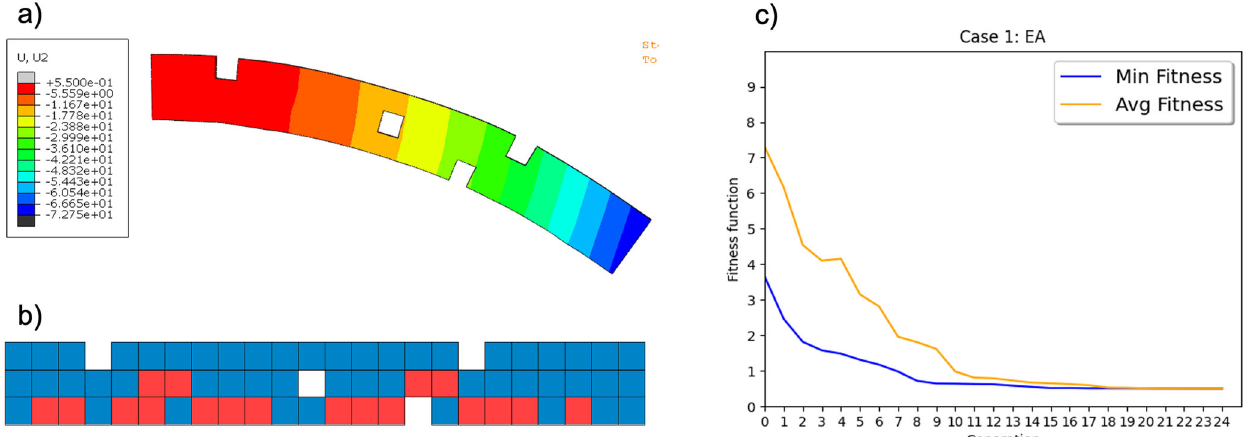
Fig. 8 The results for the fi rst case study. ( a ) the displacement of the optimal solution, ( b ) the optimal materials distribution generated by the EA, and ( c ) convergence statistics for the evolutionary